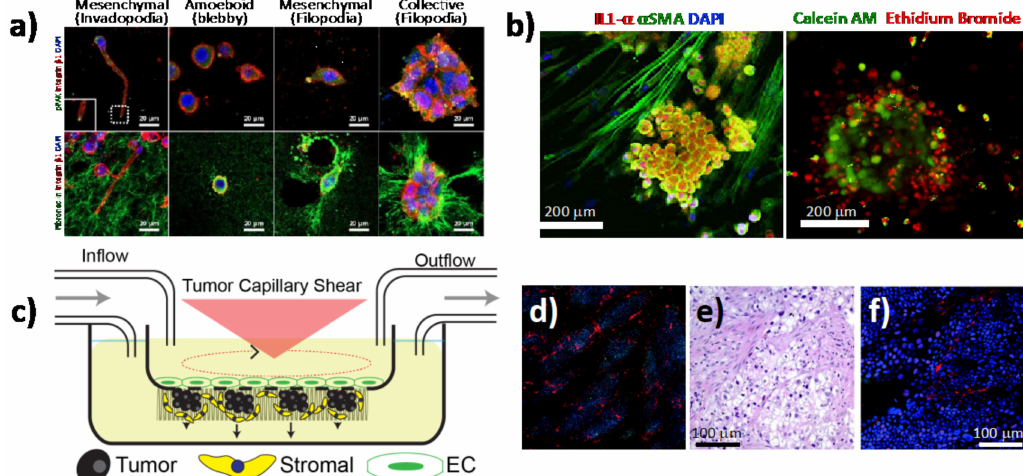
Figure 2. Heterotypic 3D in vitro models of pancreatic cancer. ( a ) Plasticity and mechanoreciprocity in pancreatic cancer (PC) cell migration and cell–extracellular matrix (ECM) interactions. Cancer cells showed individual or collective cell migration in 3D ECM environments. Individual PANC-1 cells formed actin-rich protrusions on the plasma membrane (invadopodia). PANC-1 cells showed organized ECM fibers along the direction of invadopodium growth. Individual BxPC-3 cells appeared as either a rounded shape (amoeboid) without podium formation or as a mesenchymal shape with actin-spike protrusions (filopodia). The mechanoreciprocity of cell–ECM interactions appeared to be associated with integrin-based adhesion. BxPC-3 cells showed extensive ECM deformation and unfolding around the filopodia along with a FAK-mediated traction force (adapted from [51]). ( b ) Photodestruction of fibroblasts correlates with enhanced tumor response to photodynamic therapy (PDT) using verteporfin (adapted from [53]). ( c ) Schematic of 3D in vitro tumor microenvironment system. Endothelial cells are plated above the transwell, and pancreatic stellate cells (PSCs) and PDAC cells are plated below the transwell. Tumor-derived hemodynamic force is applied above the transwell to the endothelial cells through rotation of the cone. The upper and lower chambers are independently perfused with media to recapitulate interstitial flow. ( d ) Immunofluorescence of PDAC cells (green, anti-cytokeratin 18) and PCSs (red, anti-fibroblast), nuclei stained with 4 (cid:48) ,6-diamidino-2-phenylindole DAPI. 4x composite image. ( e ) Immunohistochemistry (IHC) of a PDAC clinical sample. ( f ) Immunofluorescence stained as in the left panel (adapted from